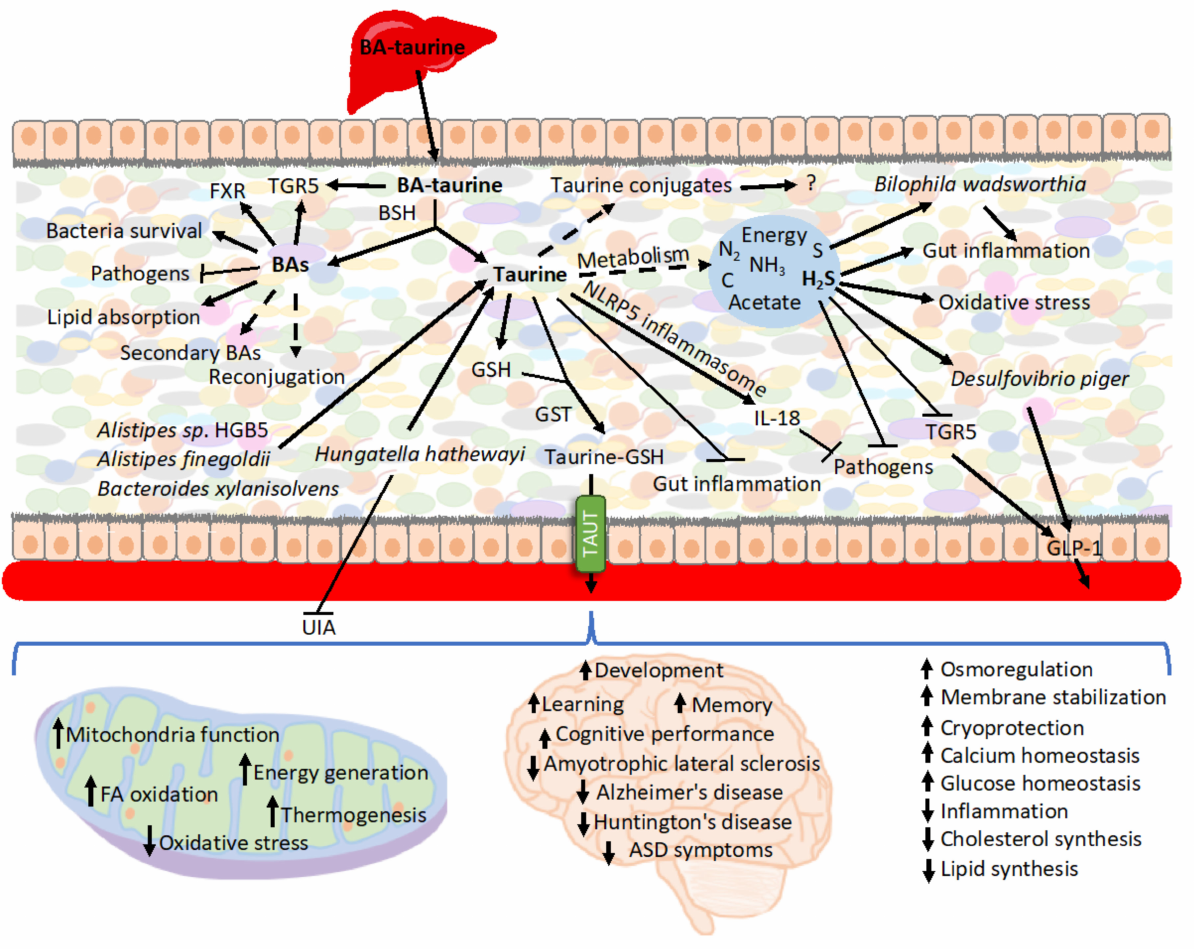
Figure 2. Summary of the roles of BAs-derived taurine. Various bacterial strains have the capacity to deconjugate BAs. The released unconjugated BAs modulate gut microbiota composition, signal various functions through its receptors, and impact nutrient uptake. BAs are also submitted mod- ifications by microbiota, including reconjugation and generation of secondary BAs. The faith of taurine released from conjugated BAs in the intestine can follow various paths. It is metabolized for energy and generates secondary metabolites, which, such as H 2 S, may play a role in interact- ing with bacteria, inflammation, and oxidative stress. Taurine also signals within the intestine to extinguish inflammation and prevent pathogens colonization. Additionally, various compounds can conjugate taurine, and, e.g., conjugation to GSH enhances taurine uptake during caloric restriction. The exported taurine plays various roles in other organs, particularly in the nerve system as well as in mitochondria all over the